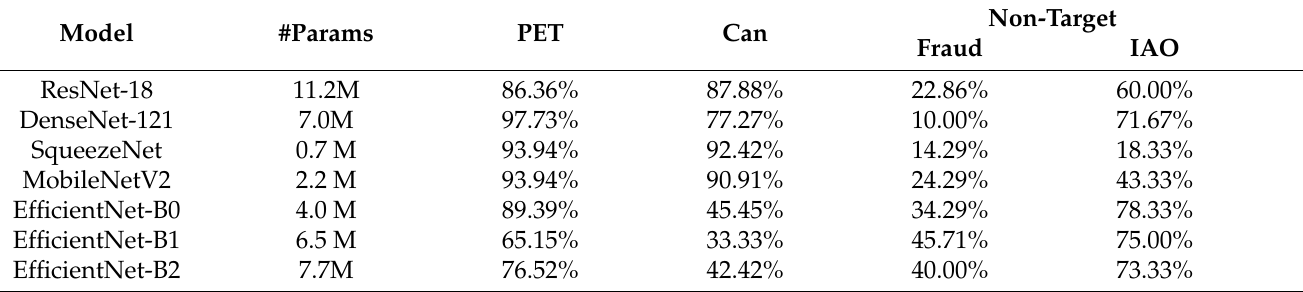
Table 3. Performance of CNNs trained with top view data, classifying objects into PET and Can classes. Heuristic threshold has been applied to distinguish non-target